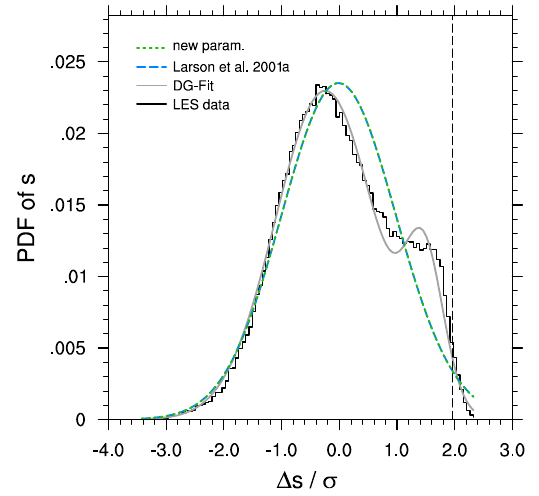
Fig. 4. Bimodal PDF of s from the RICO case at cloud base with sk = 0 . 04 . While the LES data shows a bimodal distribution and the double-Gaussian fit is able to capture this shape, the two parameterizations coincide in assuming a single-Gaussian distribution for vanishing skewness. For further explanation of the legend see Fig. 1.